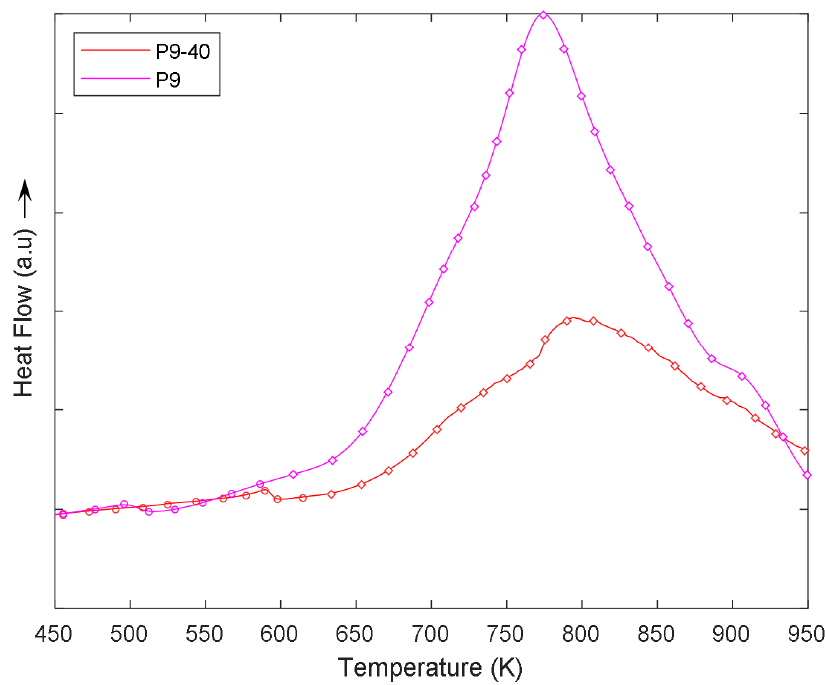
Figure 7. DSC curves for samples P9-40 and P9 to observe the effect of milling time. The scan points marked with o correspond to structural relaxations while areas with ♦ correspond to crystal growth. The comparison between the B and P samples shows how crystal growth peaks occur at a higher temperature range for B samples (B9-40, B9, B11, B13, and B15) than P samples (P9-40 and P9). By observing Figures 6 and 7, B stabilizes the alloys’ structure better than P with increasing temperature. The stability, however, depends on the atomic percentage of B, as for higher B doping, crystal growth peak temperature decreases to lower values. This implies that B samples present a higher working temperature range as crystal growth occurs at approximately 120 K above the crystal growth for samples P9-40 and P9. However, for sample B15, crystal growth occurs at similar temperatures to samples P9-40 and P9. The activation energy of the samples should be taken into consideration when study- ing the possible applicability of the analysed alloys. A higher activation energy would imply that more energy is required to start crystal growth. The activation energy obtained by Kissinger linear method for samples B9 and P9 is also significantly different. For B9, activation energy was 156 kJ/mol, while for P9, activation energy was 231 kJ/mol.